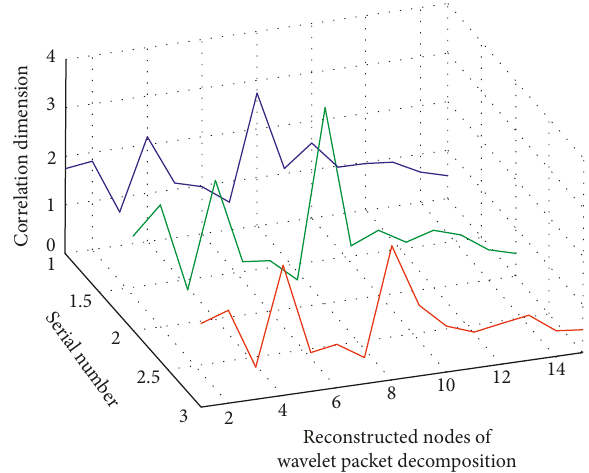
Figure 17: Correlation dimension spectra (500 r/min).